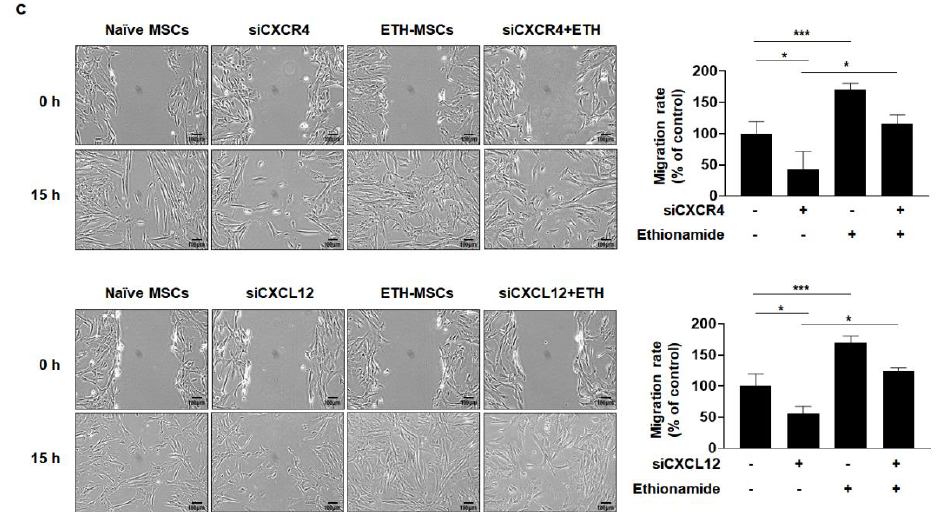
Figure 4. Ethionamide enhanced the migration ability of MSCs via the expression of CXCR4 and CXCL12. ( A ) The effects of siRNAs and ethionamide on CXCR4 and CXCL12 expression were measured by RT-qPCR. The effects of siRNAs and ethionamide on the migration ability were measured by the ( B ) Boyden chamber assay and ( C ) Wound healing assay. The results obtained from three independent experiments are expressed as the percent of untreated control ± SEM; * p < 0.05, ** p < 0.01 and *** p < 0.005 vs. untreated control. Scale bars = 100 μm